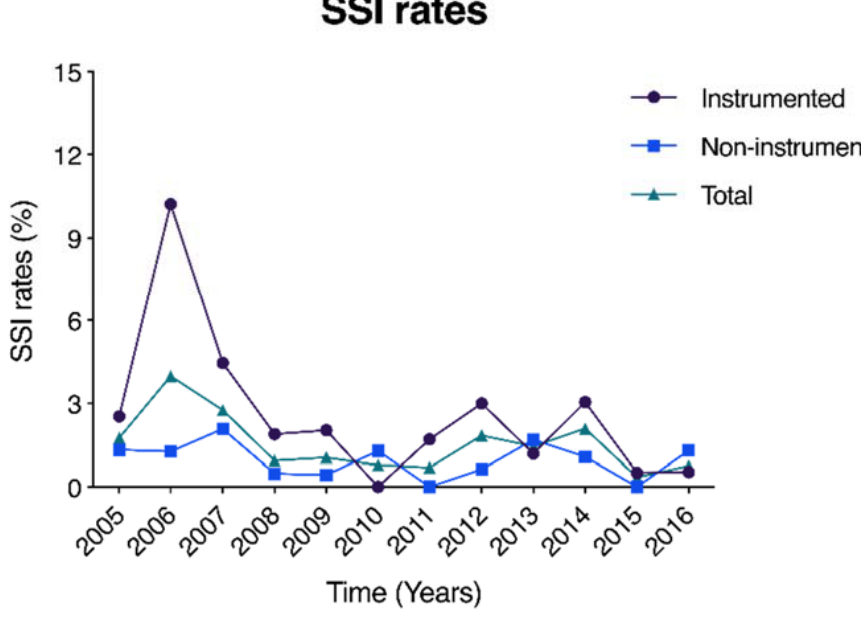
Figure 2. Graphical representation of deep surgical site infection (SSI) rates over time, given as percentage of all instrumented and non-instrumented surgical spine cases.